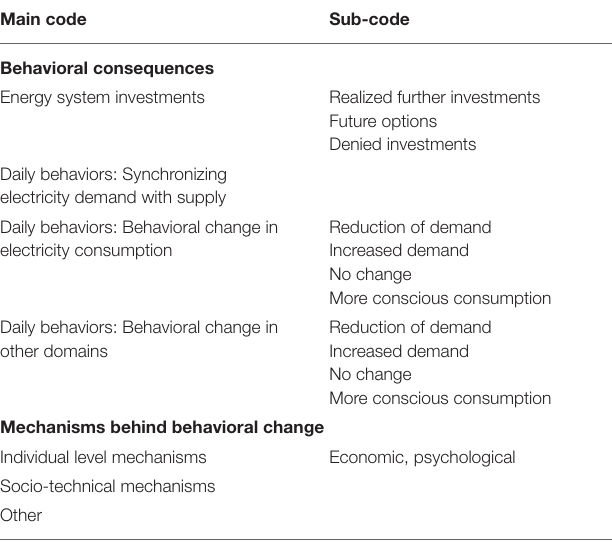
TABLE 1 | Overview on main codes and sub-codes applied to the interview